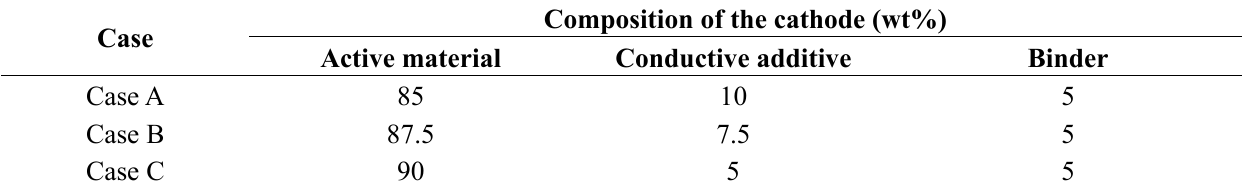
Table 2. Compositions of the lithium iron phosphate (LFP) cathode for cases